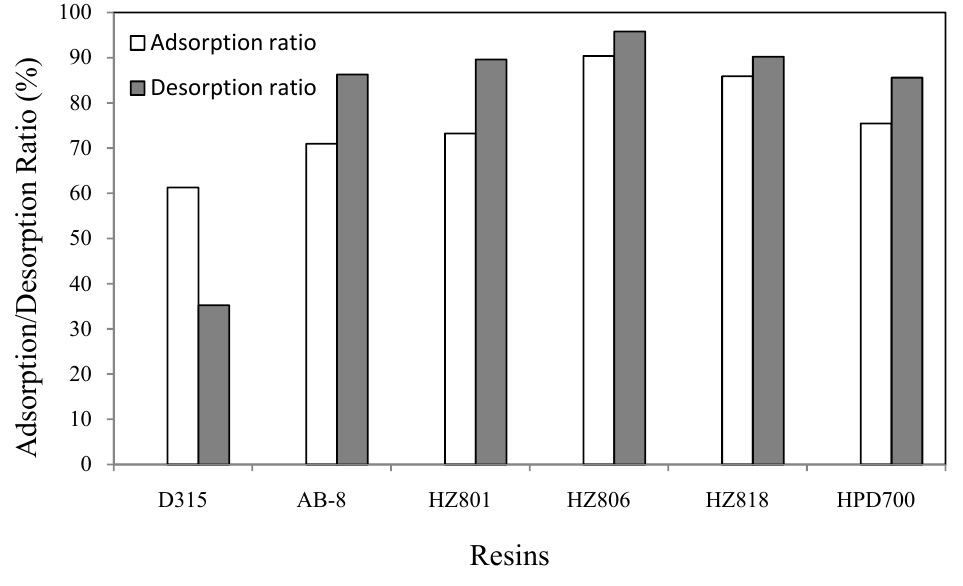
Figure 2. Adsorption/desorption ratios of mogroside V on different